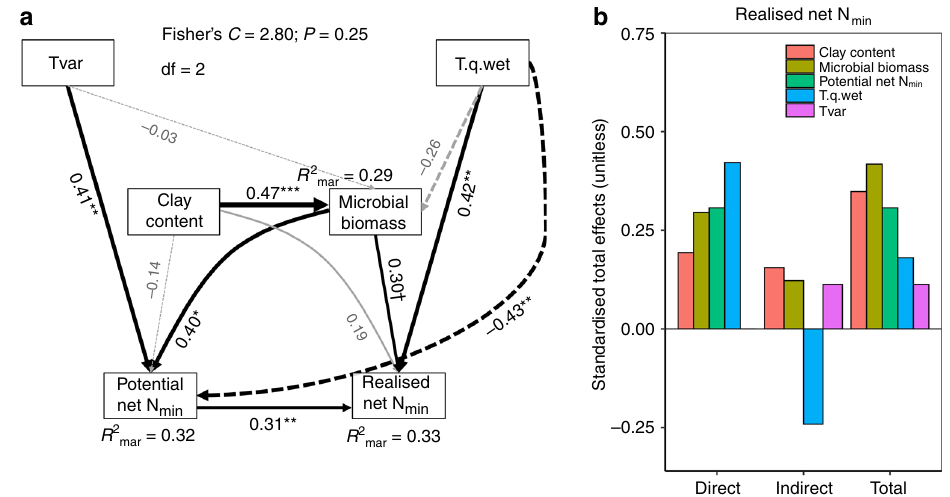
Fig. 5 Global drivers of realised soil net N mineralisation (soil net N min ). a Structural equation modelling diagram representing connections between climatic conditions, soil physical, chemical and biological properties found to in fl uence realised and potential soil net N mineralisation. The width of the connections represents estimates of the standardised path coef fi cients, with solid lines representing a positive relationship and dashed lines a negative relationship. Signi fi cant connections and R 2 are shown in black, non-signi fi cant ones in light-grey. b Standardised total, direct and indirect effects of variables associated with realised soil net N min. † p < 0.1, * p < 0.05, ** p < 0.01, *** p < 0.001. Clay content = soil clay content, Microbial biomass = soil microbial biomass, Tvar = temperature seasonality, T.q.wet = temperature of the wettest quarter. The total number of observations = 85, the total number of sites =